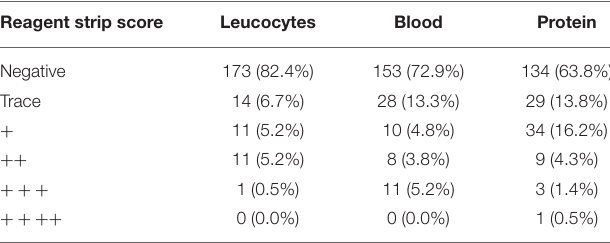
TABLE 3 | Proportion of 210 participants who submitted urine according to results of reagent